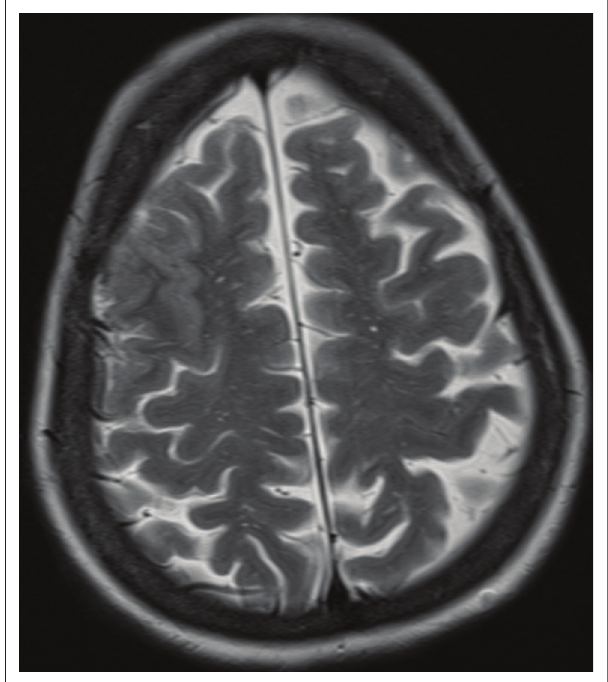
FIGURE 5: Axial T2 image.